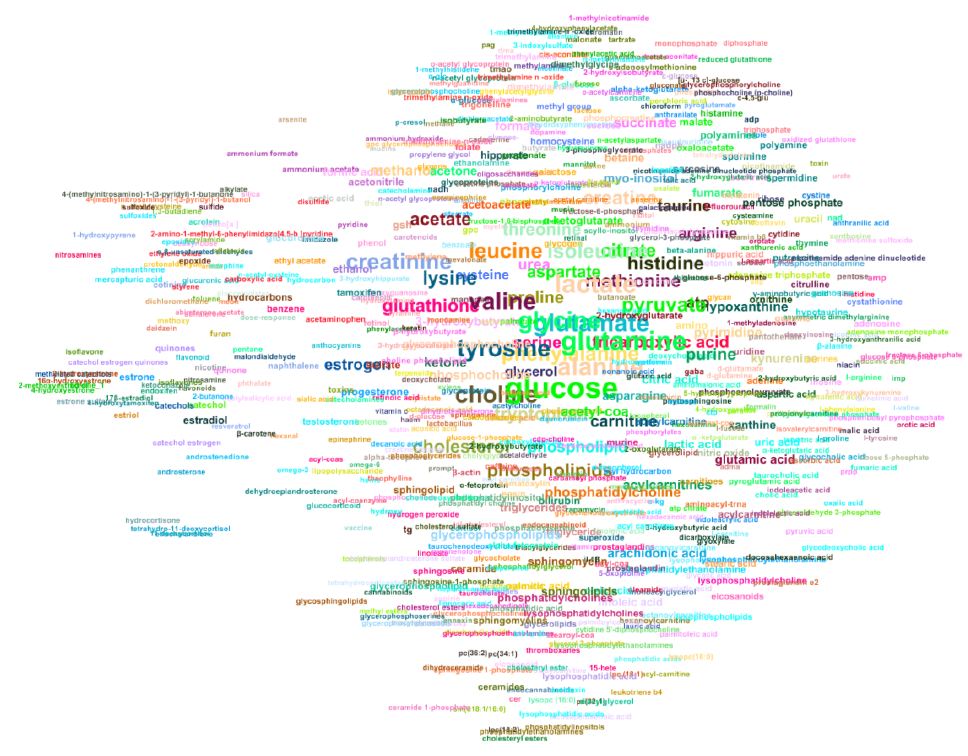
Figure 4. Graphical representation of metabolites mentioned in the abstract, results and discussion sections of 492 cancer-related metabolomics articles. Each node represents a metabolite and is displayed as the (lower-cased) metabolite name if it appeared in 3 or more articles. The closer metabolites are in the graph, they are more likely to co-occur in the same article. The text is sized proportionally to the number of articles that report the